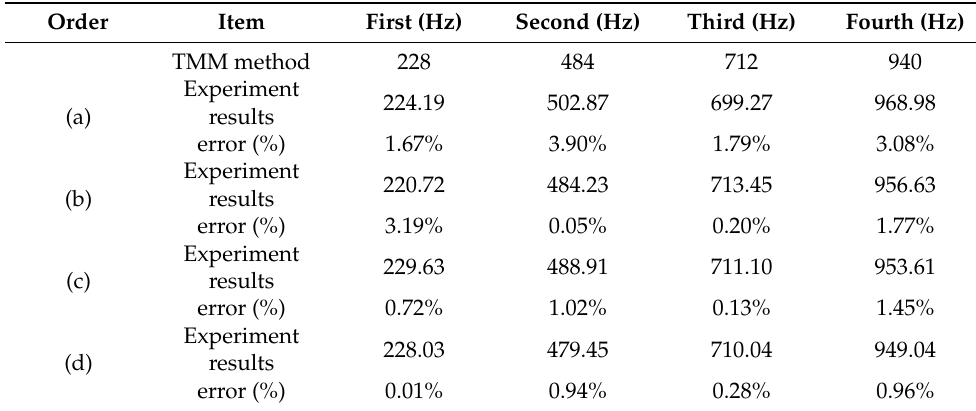
Table 12. Resonant frequencies of pipe (case